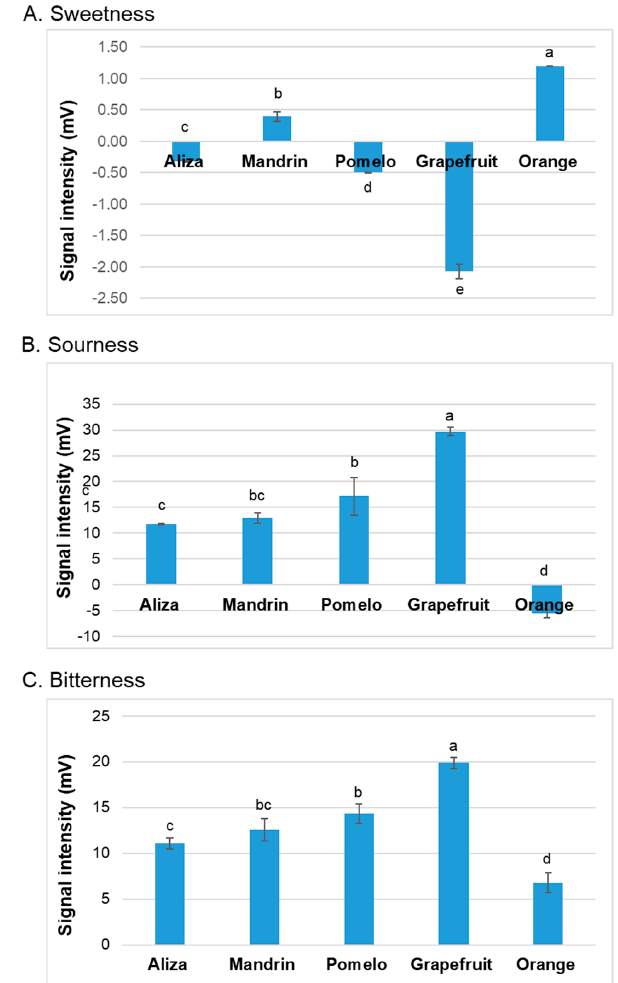
Figure 6. Taste scores of ‘Aliza’, grapefruit, pomelo, orange and mandarin fruits as determined by the e-tongue. ( A ) sweetness; ( B ) sourness; ( C ) bitterness. Data are means ± S.E. of 3 replications. Different letters indicate significant differences at α ≤ 0.05.